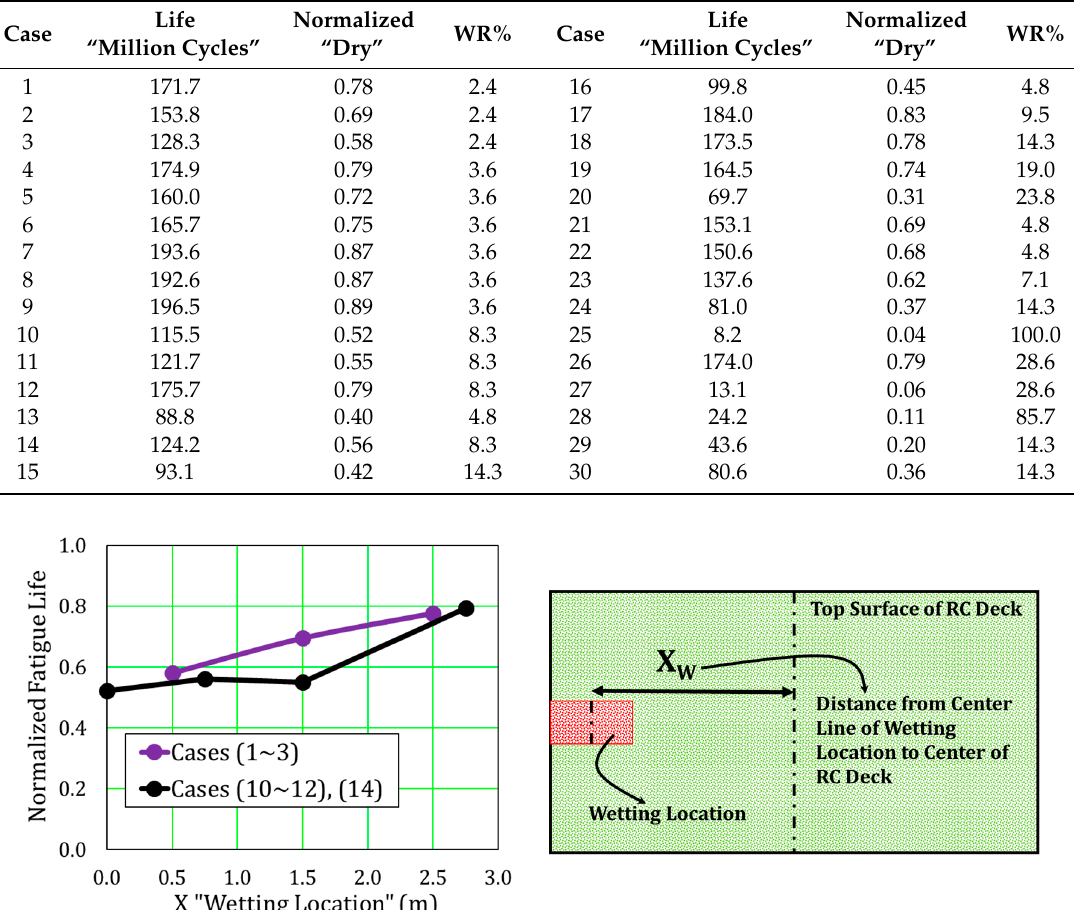
Figure 16. Effect of wetting locations on the fatigue life of RC decks.